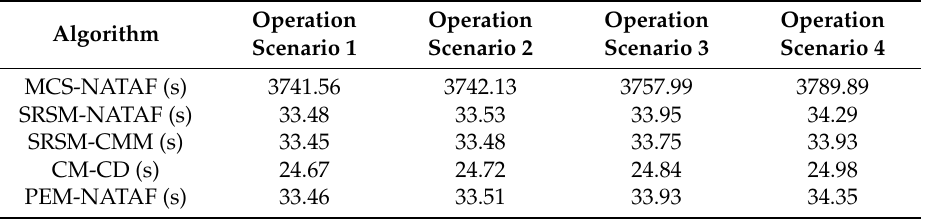
Table 7. A comparison of computing time for the four different operation